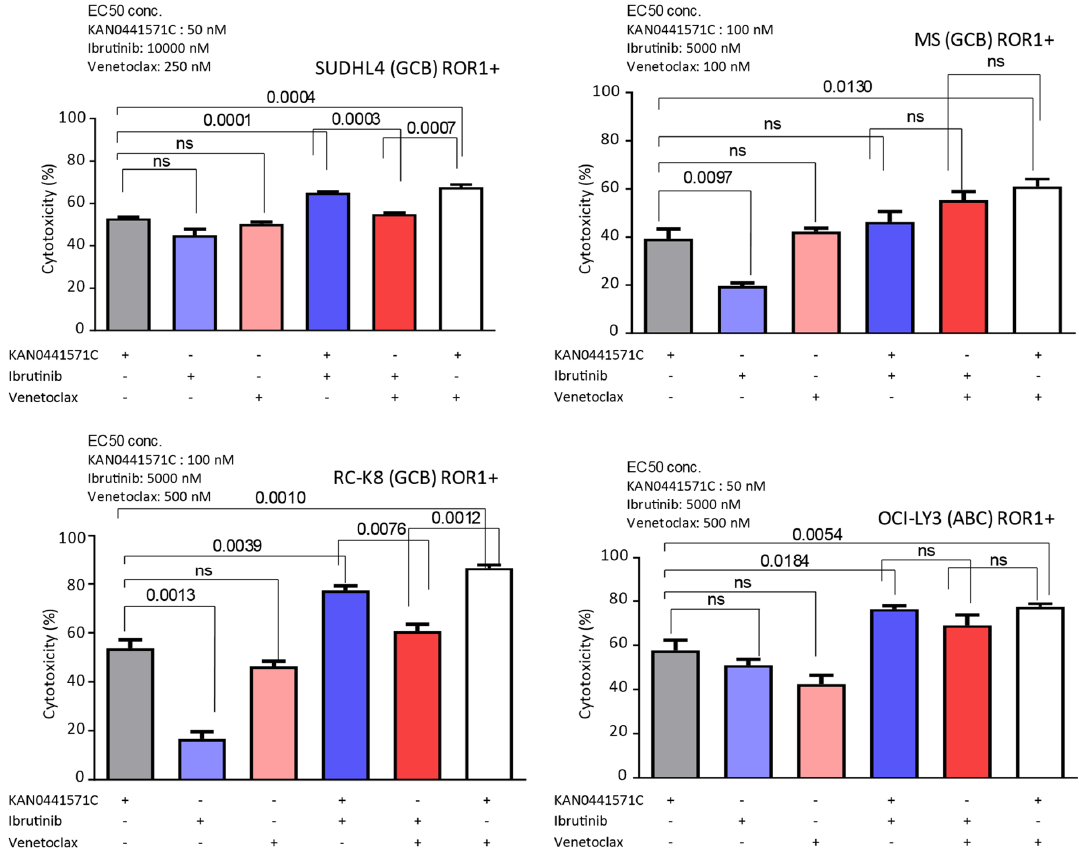
Figure 6. Cytotoxicity of four different ROR1 + DLBCL cell lines treated in vitro with combinations of EC 50 concentrations of KAN0441571C, ibrutinib and venetoclax respectively (see upper left corner) alone and in combinations. Significant differences are shown at the top. Data present the mean ± SEM of three independent experiments. Using the Bonferroni method to correct for multiple testing all p ‐ values below 0.002 remained significant while those above 0.0039 become non ‐ significant